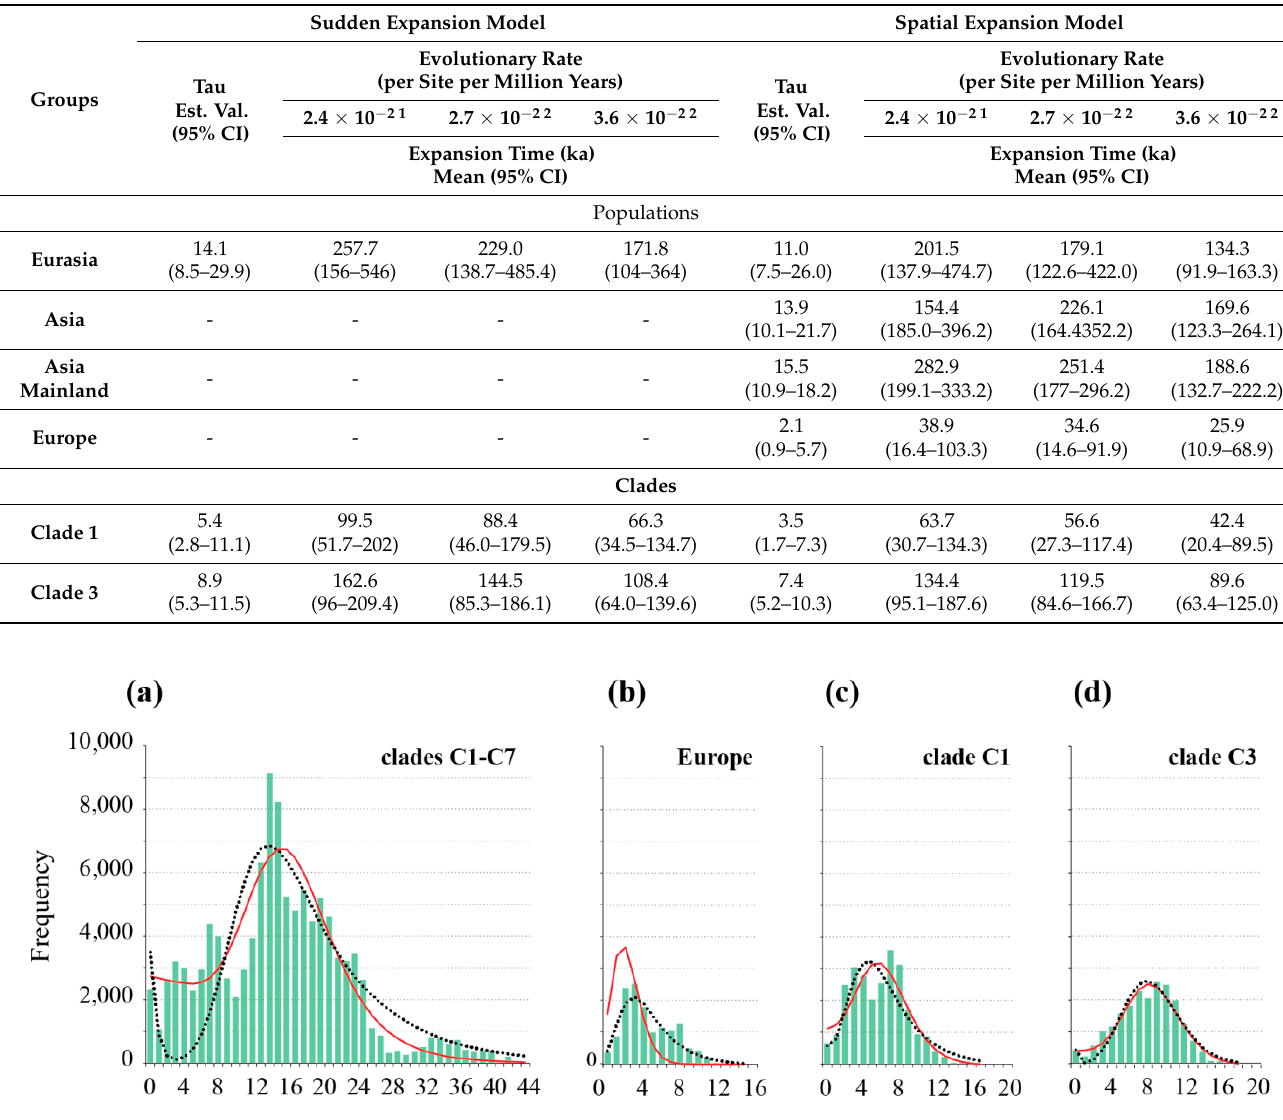
Table 3. The time of the most recent expansion, estimated using Arlequin 3.5 separately for the populations and clades of A. agrarius , based on the sudden demographic and spatial expansion models for three different mutation rates with 95% CI values. Estimated evolutionary rate: ( 1 ) 0.024/Ma [48], and ( 2 ) 0.027–0.036/Ma [49,50].